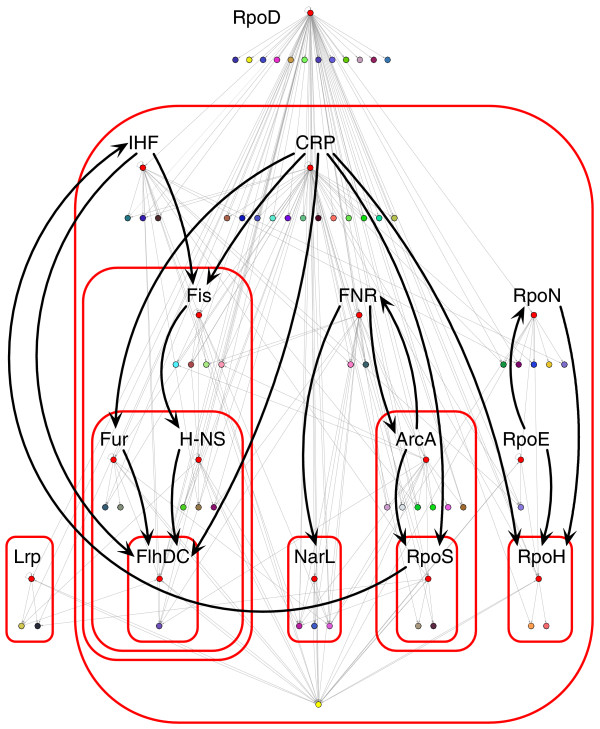
Hierarchical modular organization map of subroutines comprising the genetic program in E. coli. Each color represents a module, while hierarchical TFs are shown in red. Black arrows indicate the regulatory interactions between hierarchical TFs. For the sake of clarity, RpoD interactions are not shown, and the megamodule is shown as a single yellow node at the bottom. However, according to our data, RpoD affects the transcription of all hierarchical TFs, except RpoE, while RpoD, RpoH, and LexA (a modular TF) could affect RpoD expression. Red rounded-corner rectangles bound hierarchical layers. The presence of five global chains of command is noted: host/free-life sensor and type 1 fimbriae (Lrp); replication, recombination, pili, and extracytoplasmic elements (Fis, Fur, H-NS, FlhDC); respiration forms (NarL); starvation stress (ArcA, RpoS); and heat shock (RpoH). Lrp appears disconnected from other hierarchical TFs because, to date, it is only known that RpoD, Lrp, and GadE (a modular TF) modulate its expression.